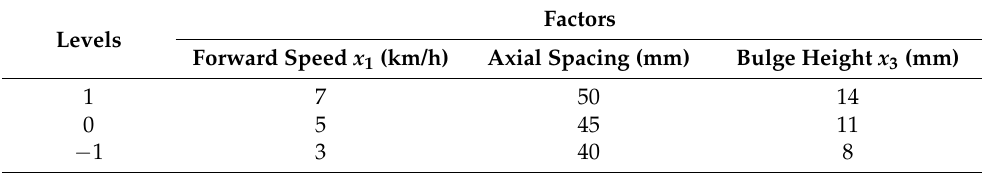
Figure 9. Validation test platform and soil adhesion. Table 2. Experimental factors and levels for the central composite face-centered method. Levels